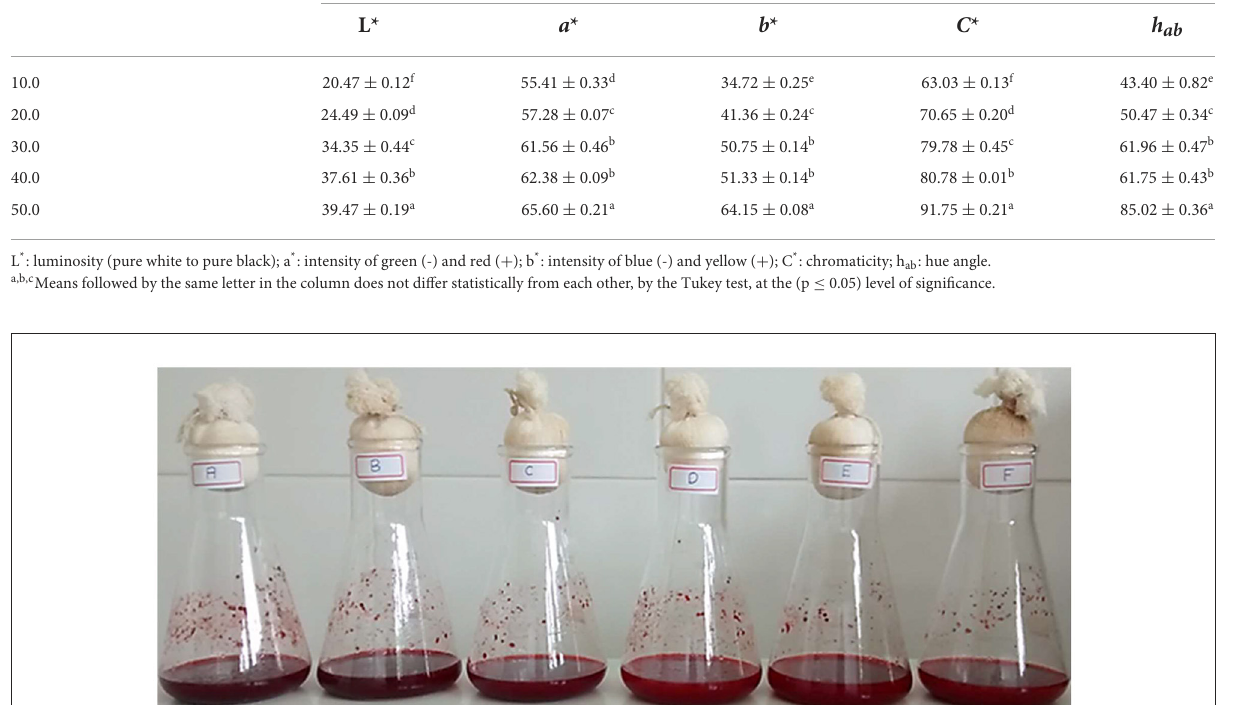
TABLE 4 CIELAB colour parameters of the pigments produced by Monascus ruber CCT 3802 grown in different concentrations of maltose syrup. − 1 Maltose syrup (g L )